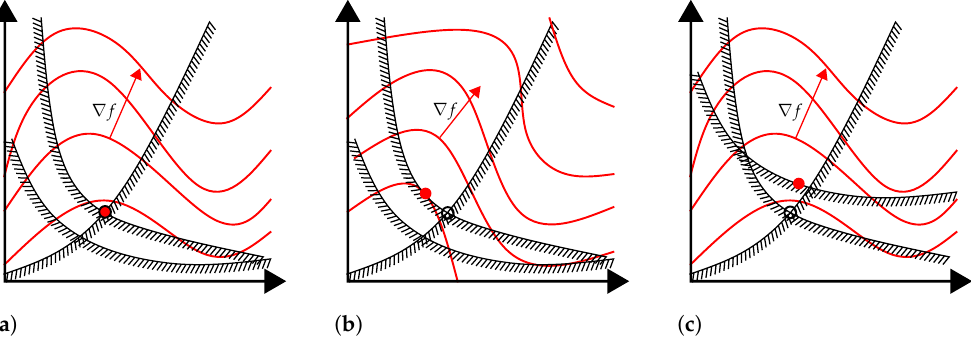
Figure 16. Consequences of an inaccurate representation of the optimisation problem. ( a ) Optimisa- tion problem solved by the MDO procedure; ( b ) Suboptimal solution: when accurately represented, the objective is different; ( c ) Invalid solution: when accurately represented, the constraints are